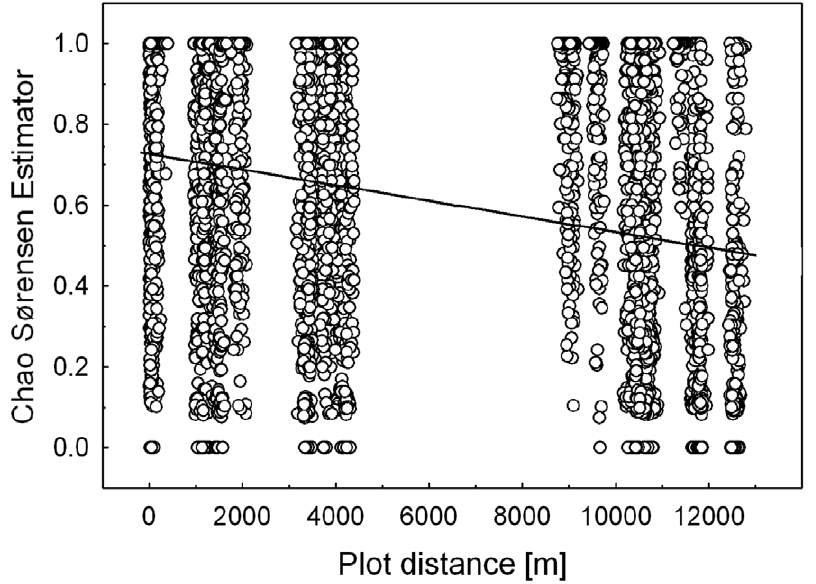
Figure 4. Distance decay of similarity of sampling points demonstrated by Chao Sørensen estimations. Statistic calculation was done with a mantel test and the inverted index (n=4950), the regression line is only given for visualization (Regression line y=0.7264 2 1.9279E-5*x).